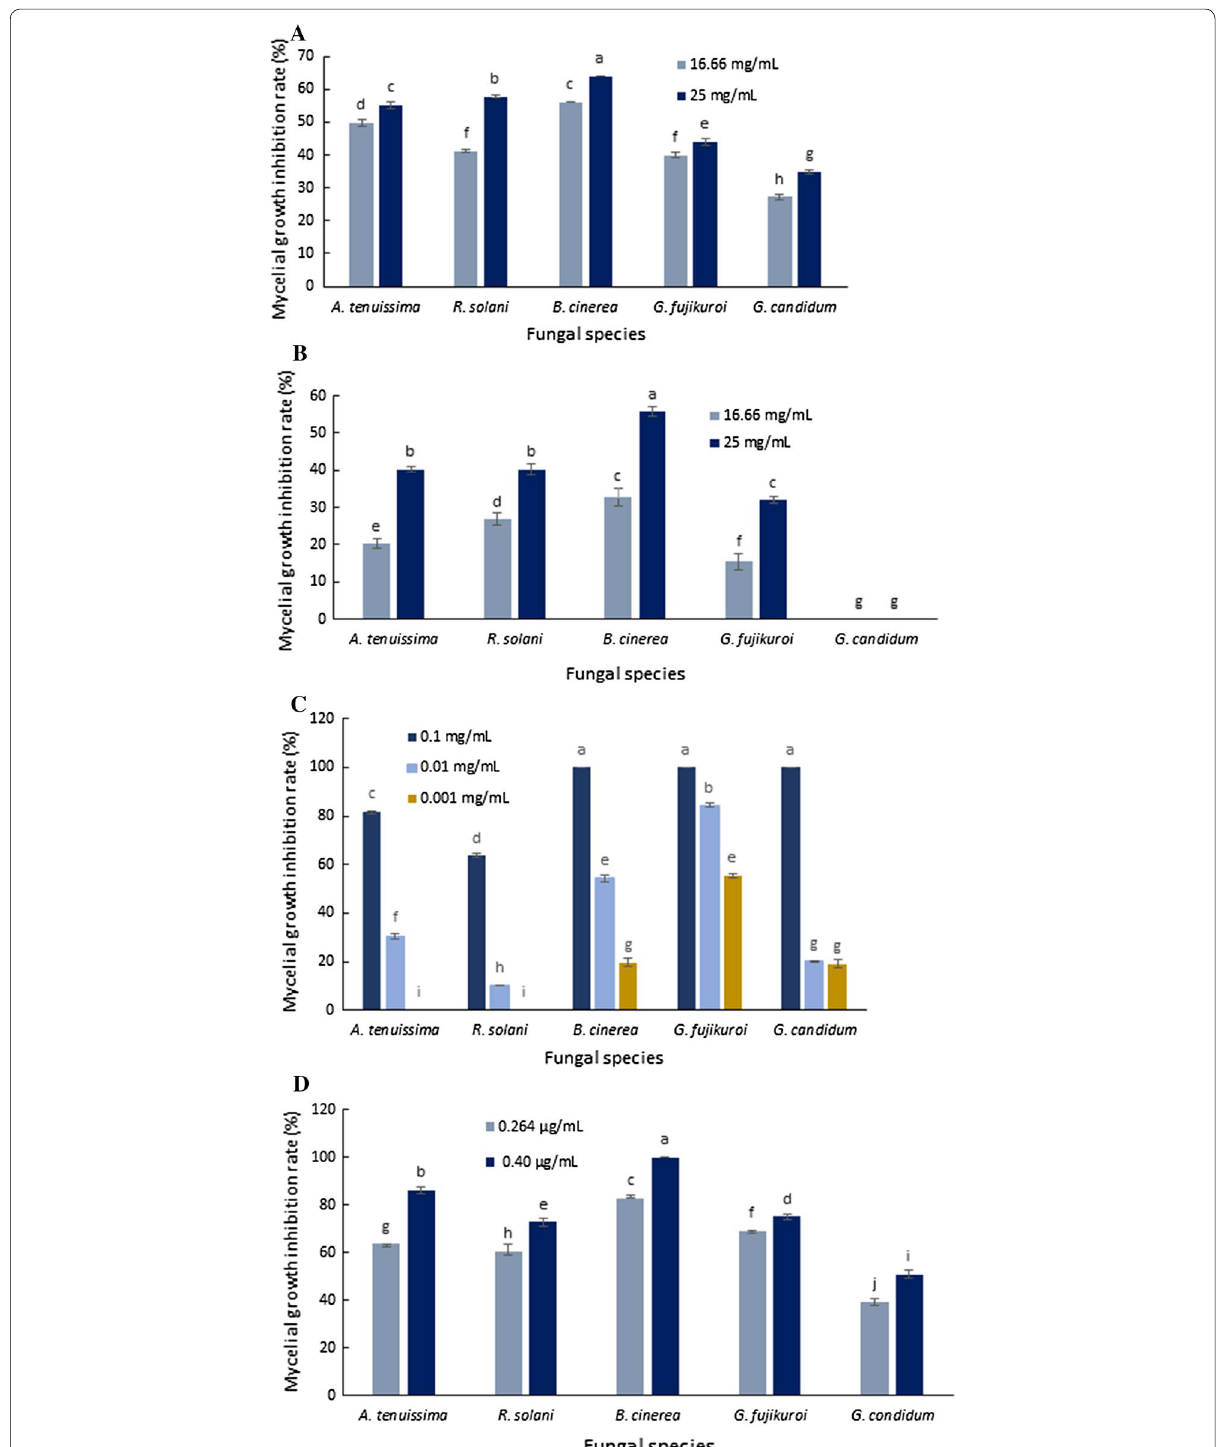
Fig. 3 Mycelial growth inhibition of different fungal plant pathogen pretreated with turmeric extract ( A ), Persian lilac extract ( B ), chemical mixture contained Mancozeb Metalaxyl ( C ) and recombinant thanatin ( D +